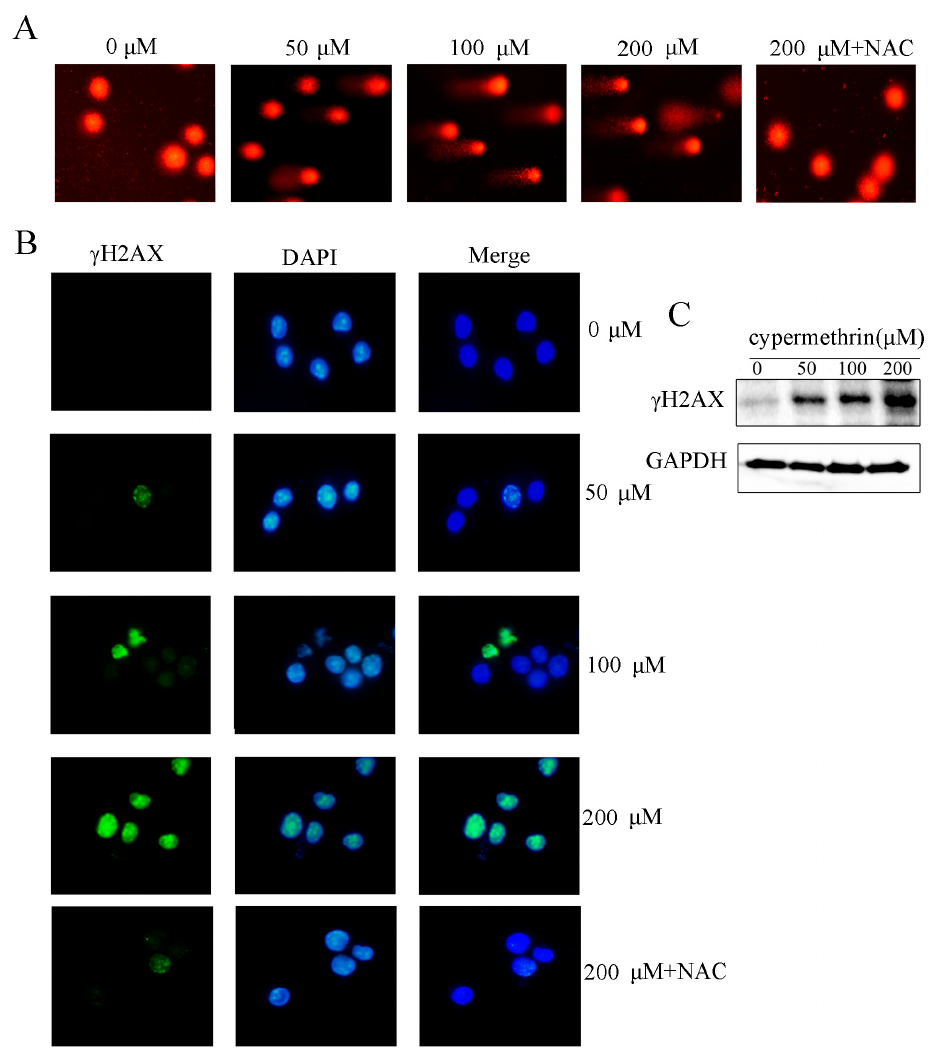
Figure 4. Cypermethrin-induced ROS generation triggered oxidative DNA damage. ( A ) The comet images of RAW cells when treated with 0–200 μ M cypermethrin, or pretreated with 5 mM NAC before 200 μ M cypermethrin treatment for 48 h; ( B ) After exposure to various concentrations of cypermethrin and pretreated with 5 mM NAC before 200 μ M cypermethrin treatment for 48 h, the γ H2AX-foci staining in each cell increased with higher concentrations of cypermethrin. The γ H2AX foci exhibited in green stained by fluoresce isothiocyanate (FITC), and the nuclei exhibited in blue stained by DAPI. (Magnification, ×400); ( C ) The expression level of γ H2AX was also examined by Western blot in RAW cells treated with cypermethrin for 48 h.